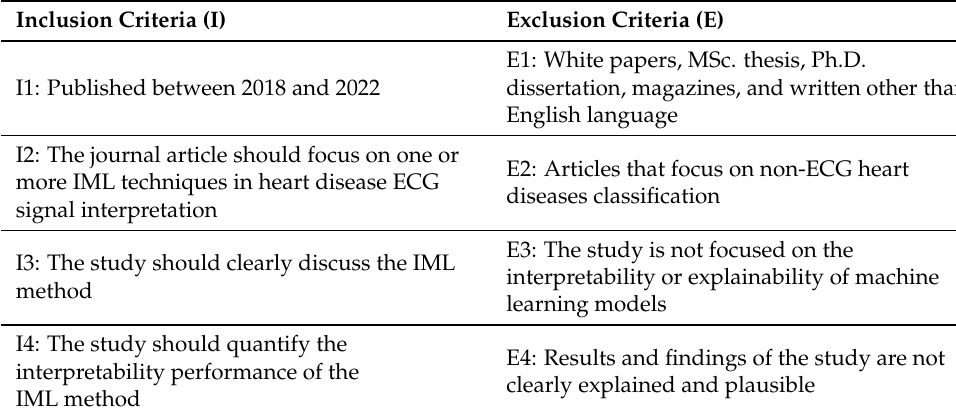
Table 3. Literature inclusion and exclusion